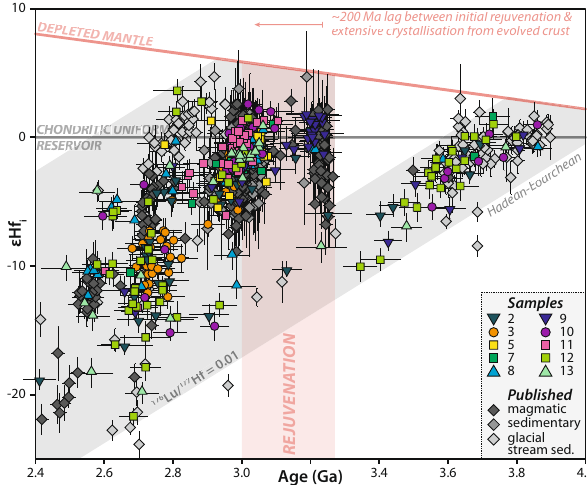
Fig. 4 Zircon ε Hf isotope evolution diagram. Zircon ε Hf isotope evolution diagram showing that the most evolved compositions at any given time period correspond to a Hadean-to-Eoarchean crustal source. Note major addition of juvenile material at c. 3.2 Ga. Depleted mantle values: 176 Lu/ 177 Hf = 0.0388, 176 Hf/ 177 Hf = 0.28325 68 . CHUR values: 176 Lu/ 177 Hf = 0.0336, 176 Hf/ 177 Hf = 0.282785 65 . λ 176 Lu = 1.867 × 10 − 11 a − 1 64 . Published datasets are from Gardiner et al. 17 and Yi et al. 20 . Shaded fi eld highlights limits of the dataset in this work. Error bars are shown at two standard errors. Source data information for this fi gure is provided in Supplementary Data